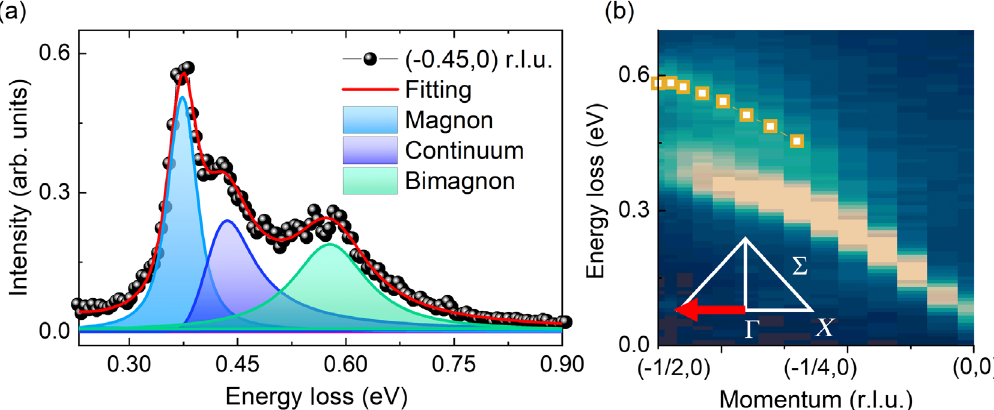
FIG. 4. (a) High-resolution (approximately 26.3 meV) spectra acquired at ( − 0 . 45 ,0) using σ polarization. The use of high resolution clearly allows us to disentangle the single-magnon peak and the bimagnon peak from the high-energy tail. (b) Map of RIXS spectra along the Γ → ( − X ) line, acquired with σ incident polarization and grazing-in geometry. Momentum values are reported with positive signs for clarity. The energy of bimagnon excitations extracted with a fitting is highlighted in yellow